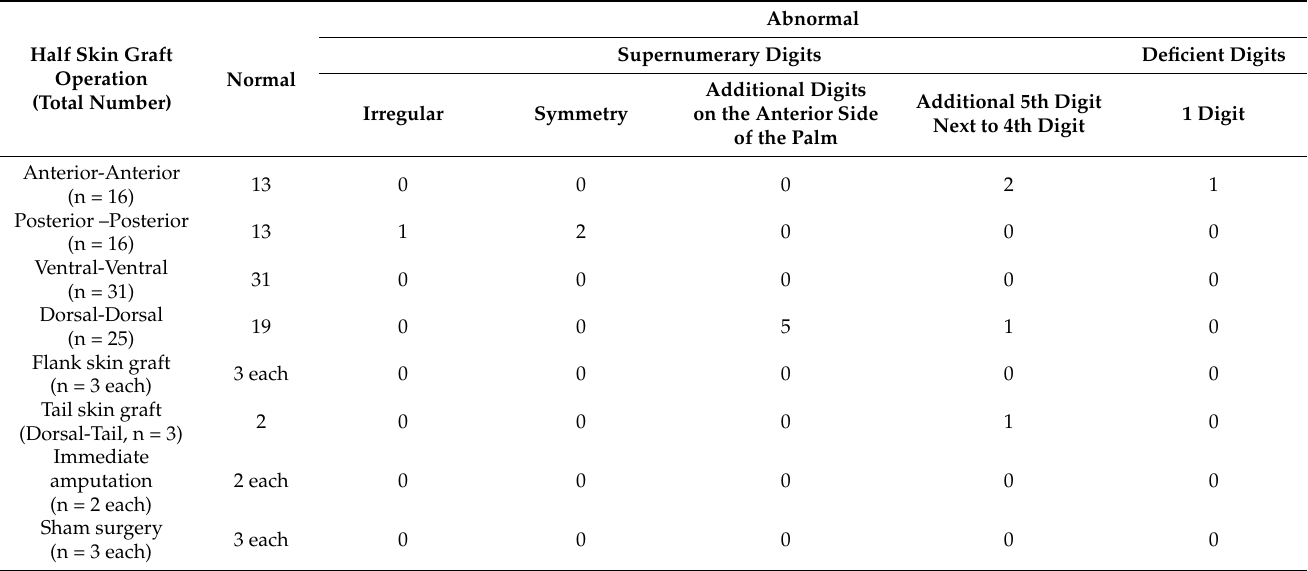
Table 2. Effects of half skin graft operation on the axial pattern of the regenerating